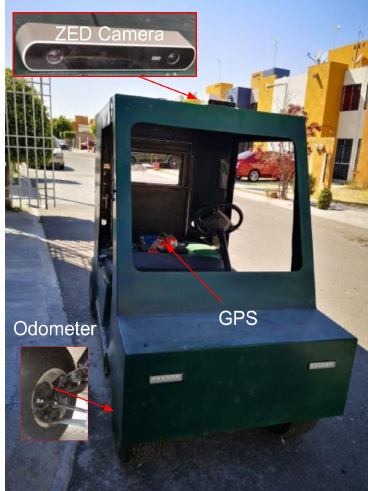
Figure 1. Electric vehicle used for data collecting.